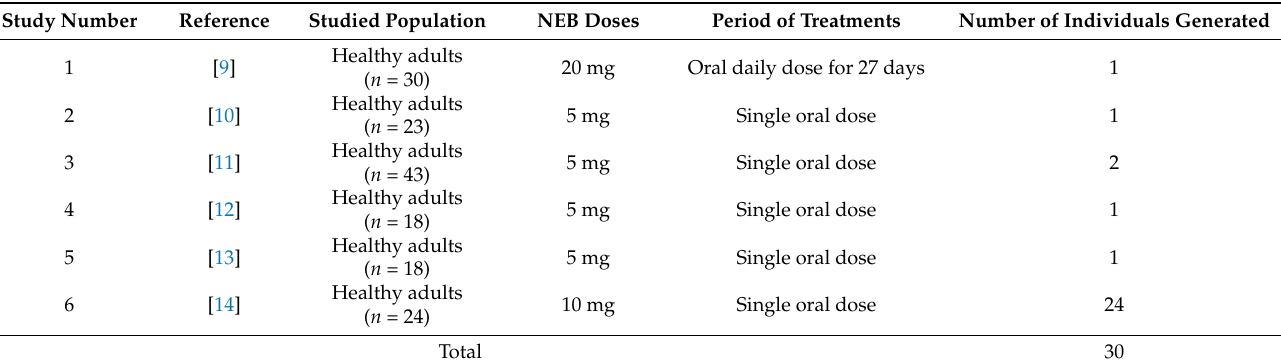
Table 2. Summary of published literature reports on NEB pharmacokinetics.